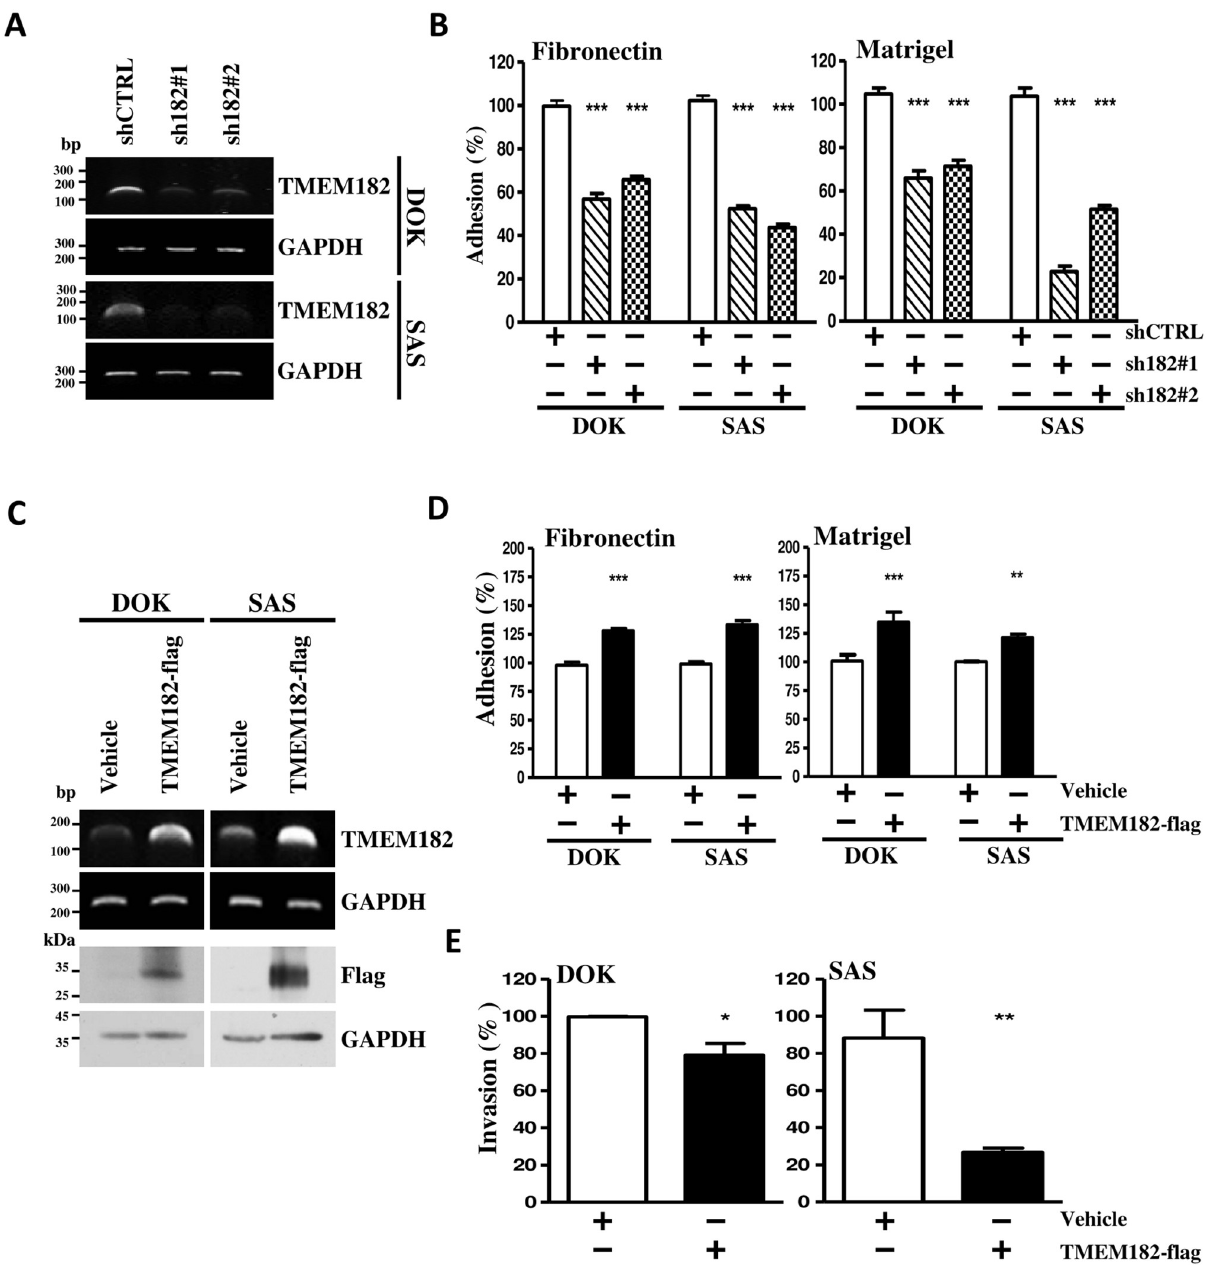
Fig 3. TMEM182 decreases OSCC cell motility. (A) RT-PCR analyses were performed to detect mRNA expression level of TMEM182 in DOK and SAS cells transfected withTMEM182 knockdown clones-shRNA clone 1 (sh182#1), clone 2 (sh182#2), or empty vector (shCTRL). GAPDH was used as a loading control. (B) Suppression of cell adhesive ability was found in TMEM182-knockdown cells towards to fibronectin and matrigel. (C) RT-PCR and Western blot analyses measured the levels of TMEM182 in vehicle or TMEM182-flag transfected cells. GAPDH and α -tubulin were used as loading controls. (D-E) Cell adhesion and invasion analyses of TMEM182 overexpression in DOK and SAS were measured. Data was represented as mean ± SEM; � P < 0.05; �� P < 0.01; ��� P < 0.001.